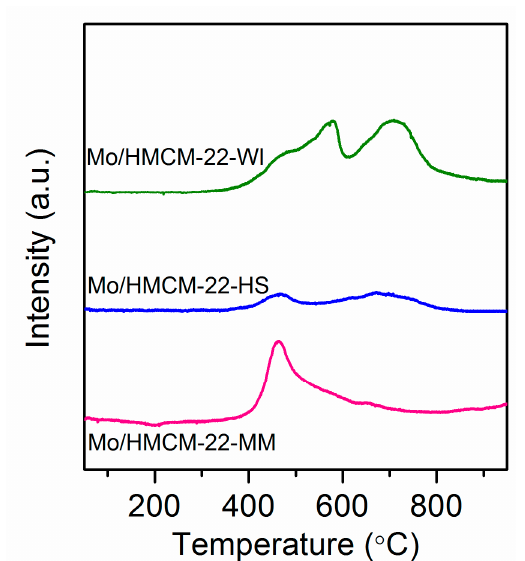
Figure 5. H 2 -TPR profiles for the Mo/HMCM-22-HS, Mo/HMCM-22-WI and Mo/HMCM-22-MM catalysts.